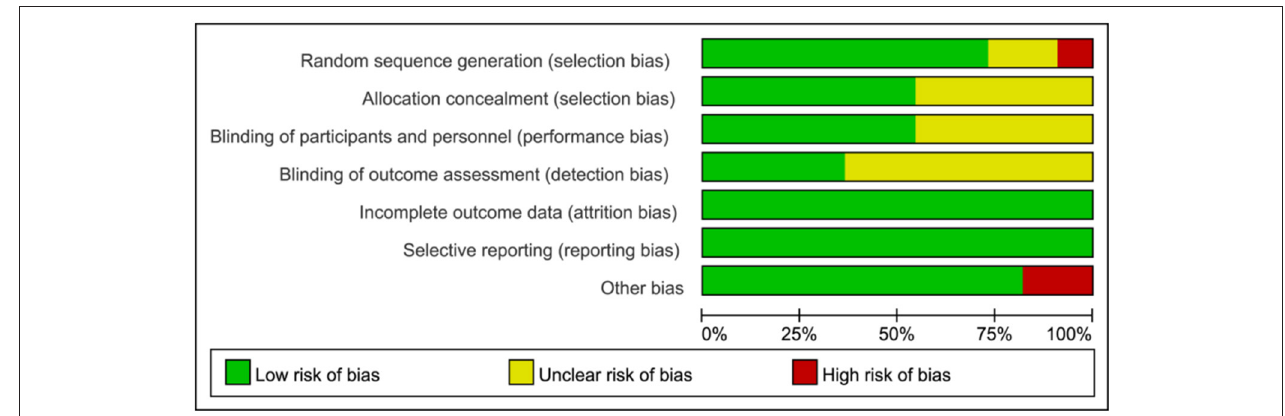
FIGURE 2 | Risk of bias graph each risk of bias item presented as percentages.